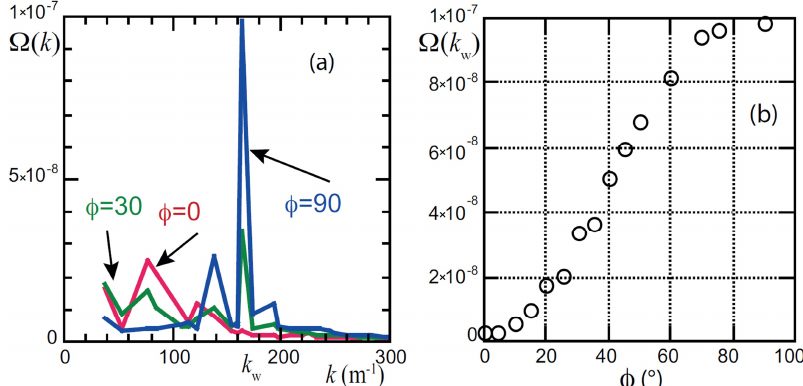
Figure 8. ( a )Wave number spectrum of the enstrophy Ω ( k ) for different phase shifts φ = 0,30 ◦ ,90 ◦ . ( b ) The onset of the spatially ordered flow is seen as an exponential growth of the peak of the spectrum Ω ( k w ) with an increase in the phase shift in the range of φ = (0–70) container, f = 4.58 Hz, λ = 80 mm, a / λ = 0.1.